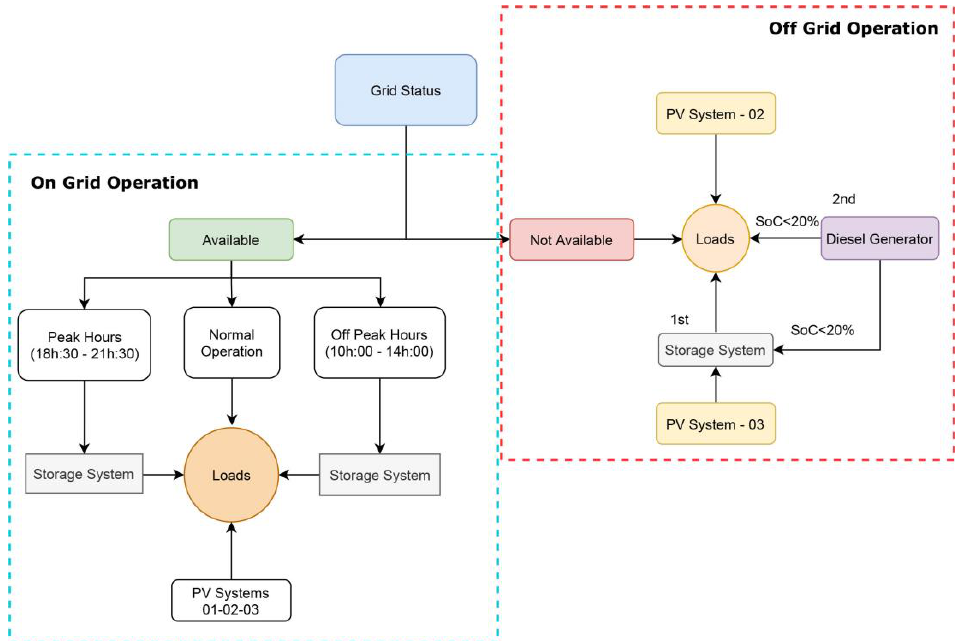
Figure 6. Hybrid system operation configurations flowchart.